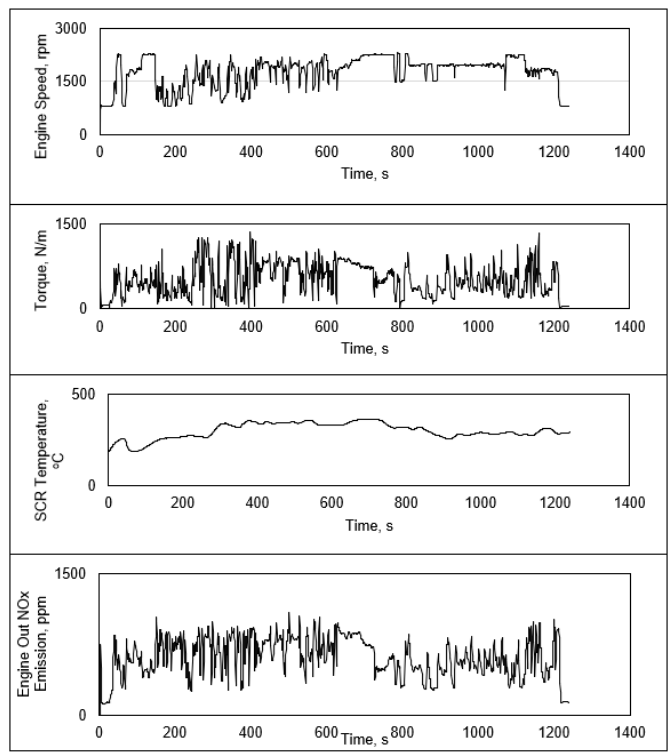
Figure 2. Parameter variation in an NRTC emission cycle.